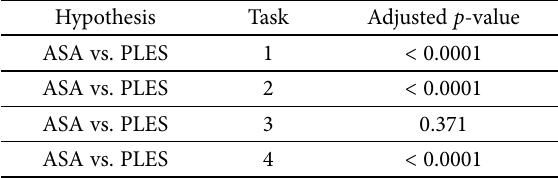
Table 21. Multiple comparisons with the Bergmann–Hommel procedure for free